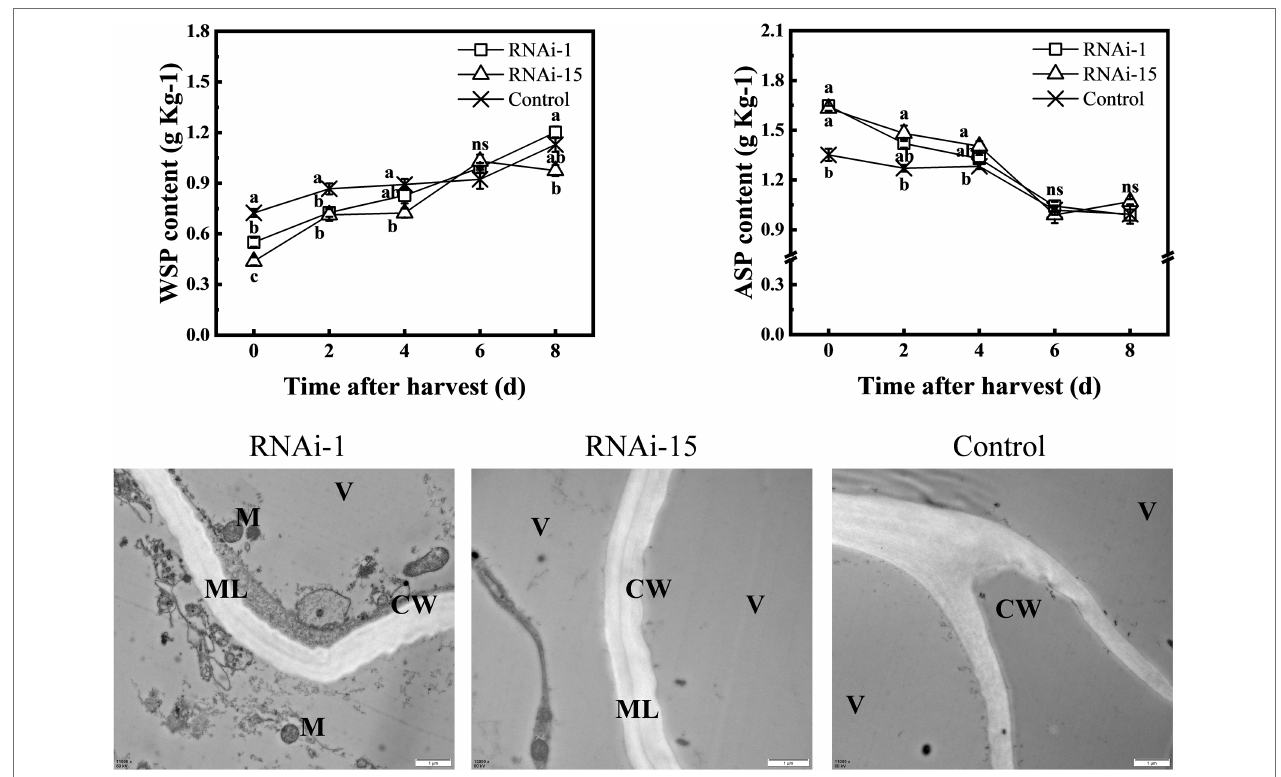
FIGURE 9 | Change in contents of water-soluble pectin (WSP) and acid-soluble pectin (ASP), and cell wall ultrastructure. Cell wall ultrastructure was observed by transmission electron microscopy (TEM). The bars = 1 μ M. ML, intercellular layer; CW, cell wall; M, mitochondrion; and V, vacuole. Each values represents the means ± standard error of three replicates. Significant differences ( p < 0.05) between means are indicated by different